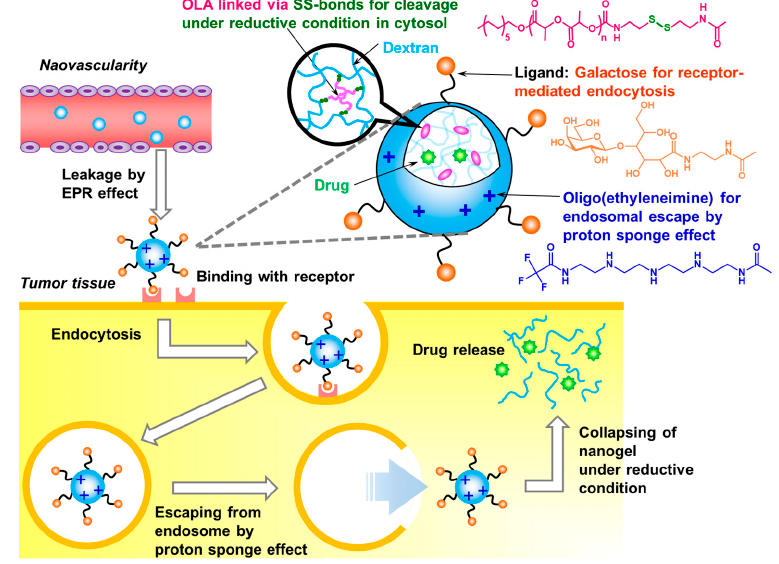
Figure 1. Schematic illustration for the concept of this work and the design of nanogel. EPR: enhanced permeability and retention, OLA: oligolactide, SS: disulfide.